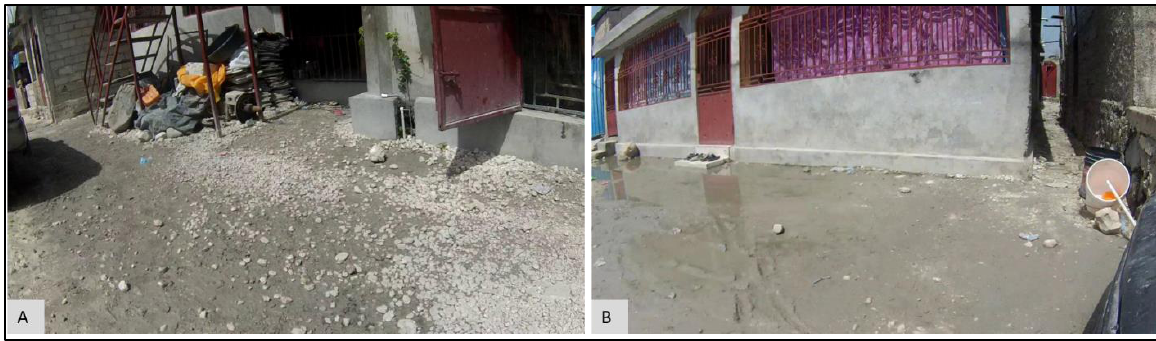
Figure 13. SV imagery for July 2017 for: ( A ) water point M1, ( B ) water point M13.